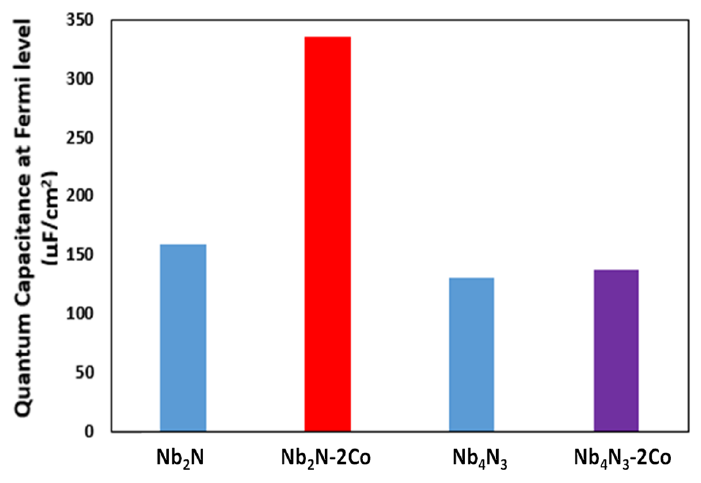
Figure 9. Comparison of calculated QC for pristine and doped polarized structures at Fermi level.